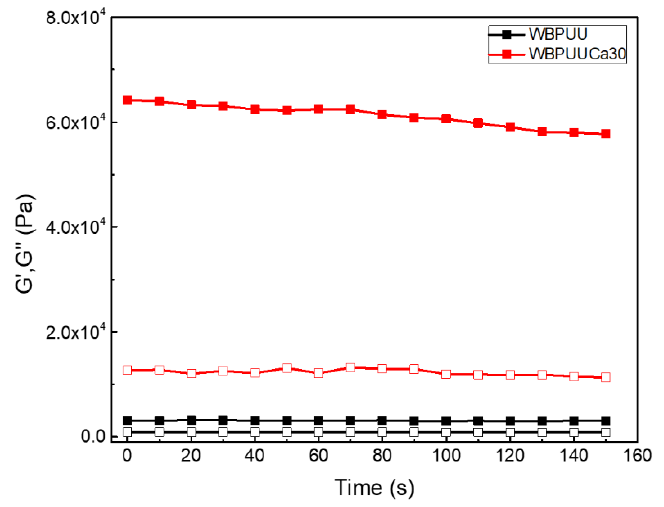
Figure 4. Storage ( ■ ) and loss ( □ ) moduli as a function of time at a frequency of 1 Hz and a strain of 1% (T = 22.5 °C) for WBPUU before and after the immersion in CaCl 2.